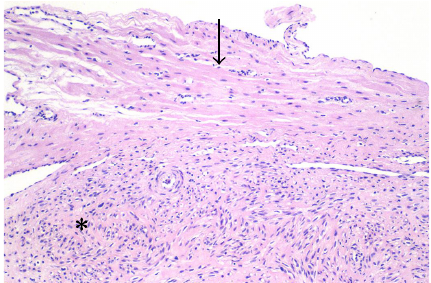
Figure 4: Phenotypic transformation: loss of parallel orientation of fibers. The parallel, linear orientation of the myometrial smooth muscle cells (arrow) contrasts with the haphazard, disorganized arrangement of the fibroid tumor cells (asterisk). Original magni- fication: